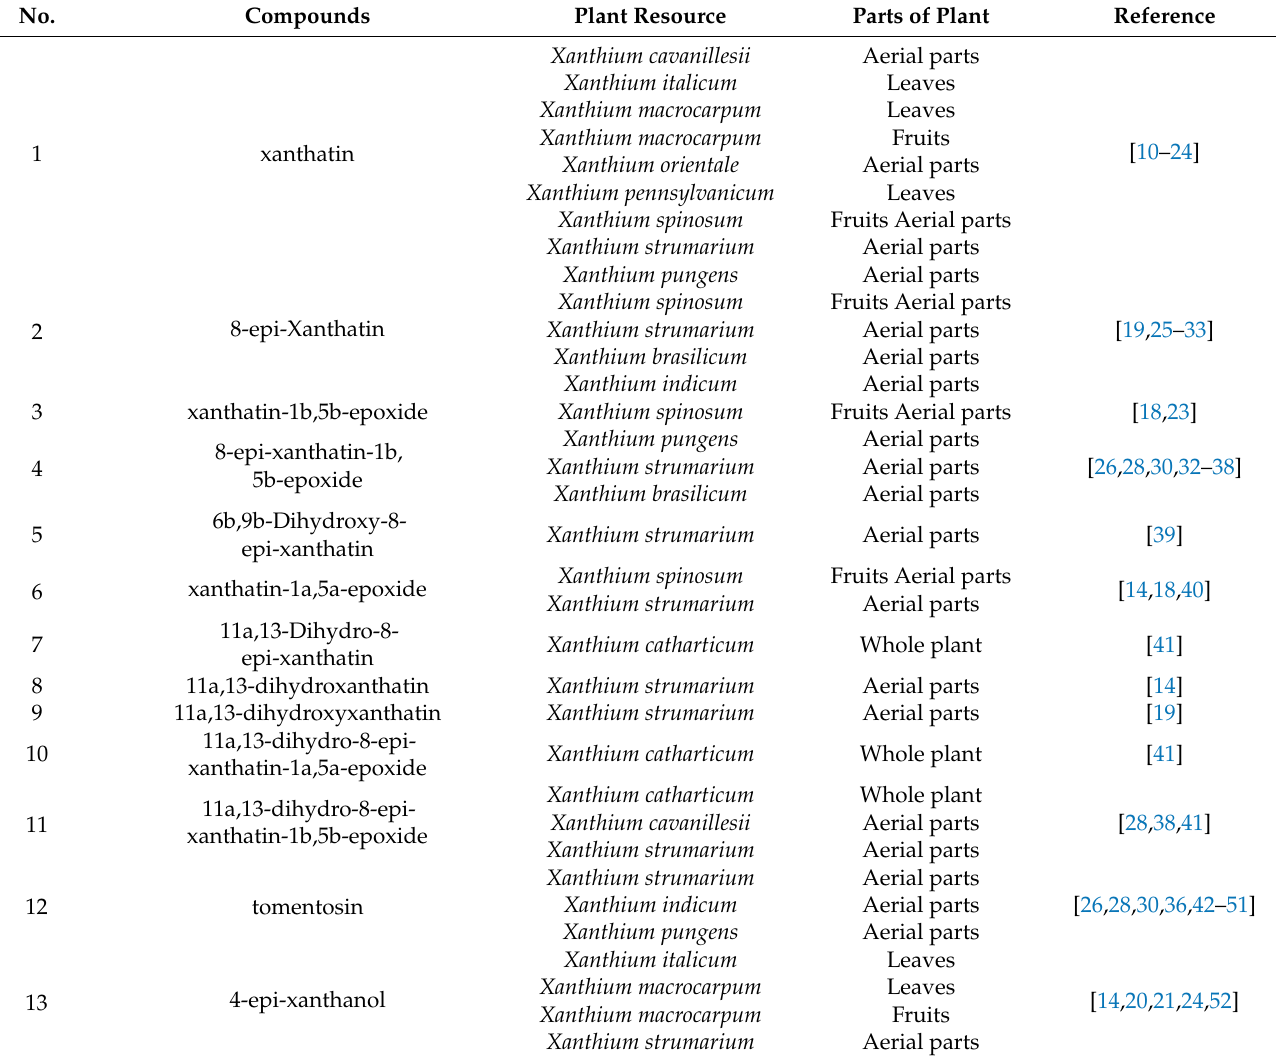
Table 1. Xanthanolides isolated from X. strumarium